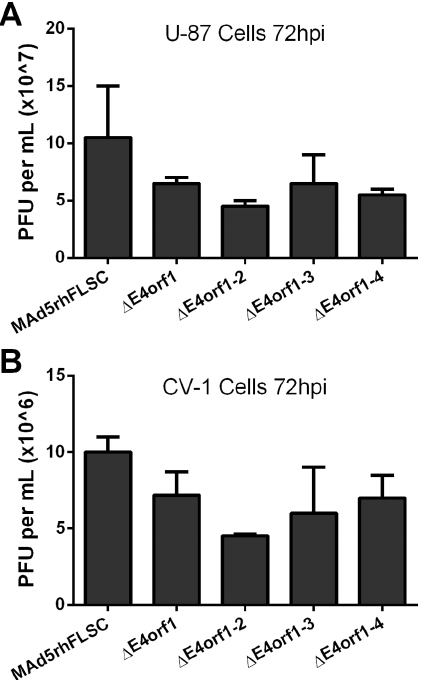
Figure 2. Deletion of E4orf1 through E4orf4 has little effect on viral progeny production. ( A ) U-87 cells were infected with the listed viruses at an MOI of 5 PFU/cell for 72 hours. The cells were collected and after three rounds of freezing-thawing the media were used to infect 293 cells as described in Materials and Methods. The plaques were counted and numbers graphed and analyzed. No significant differences between the parental and E4 -deleted viruses were obtained using one-way ANOVA (p . 0.05). The values shown are the means of 2 independent infections 6 SEM. ( B ) The results were confirmed in CV-1 cells (p . 0.05).